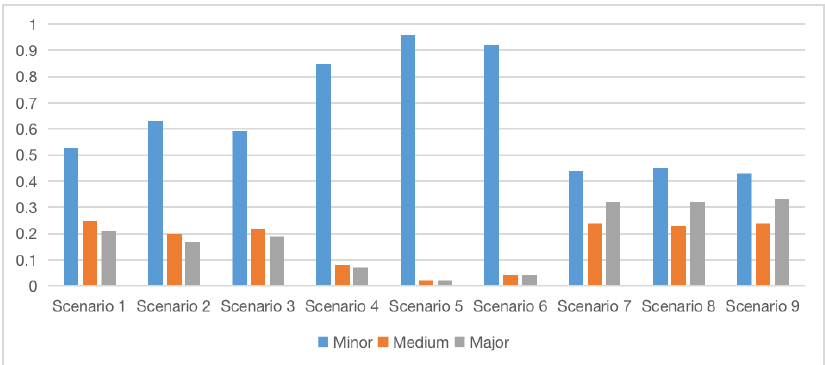
Figure 6. Estimated probabilities of “J. Whether the attack is successful” under different scenarios. Int. J. Environ. Res. Public Health 2020 , 17 , x FOR PEER REVIEW